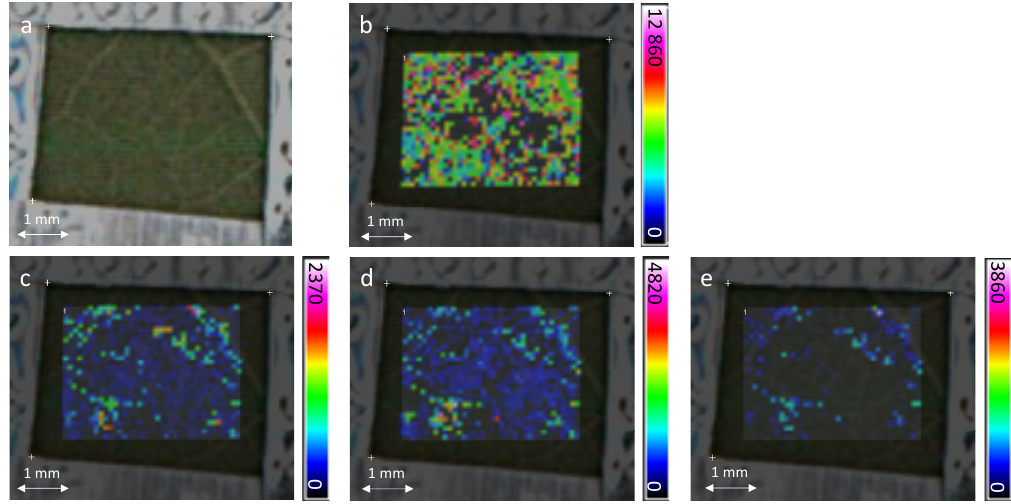
Figure 4. MALDI-MSI of UV stressed grapevine leaf ( a ) optical image; ( b ) ion extracted image related to one peak of the matrix [DHB-H O+H] + ( m/z 137); ( c ) ion extracted image 2 of resveratrol and piceids ( m/z 229); ( d ) ion extracted image of pterostilbene ( m/z 257); ( e ) ion extracted image of viniferin ( m/z 454 and 455). The color scale indicates the absolute intensity of each pixel (arbitrary